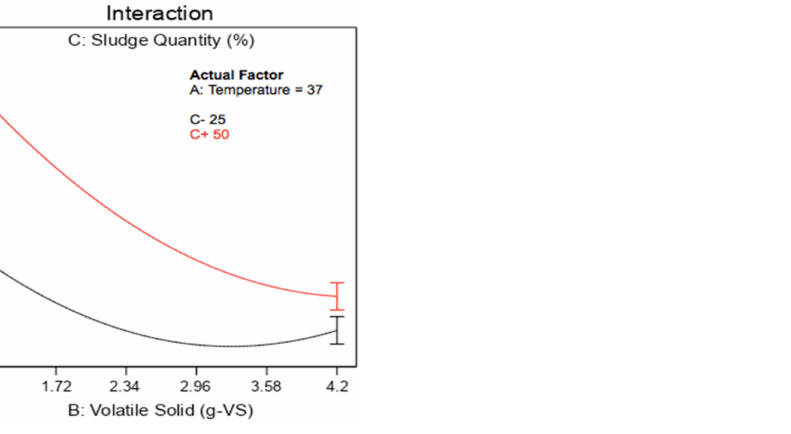
Figure 25. Interaction Plot clarifies the effect of interaction between volatile solid and sludge quantity on biogas/g-VS.